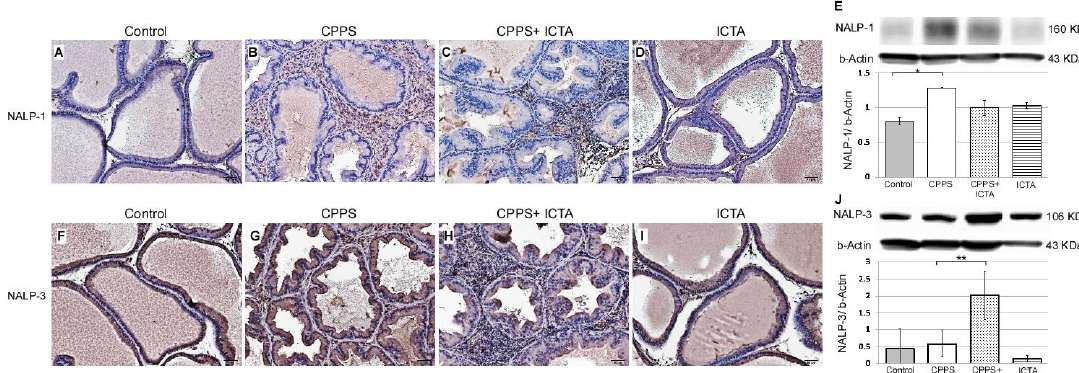
Figure 4. Inflammatory cytokine-targeting aptamers (ICTA) attenuated local carrageenan exposure-induced increases in inflammasome activation (NALP1) in rat prostate, but promoted NALP3 formation 168 h after carrageenan injection. ( A , B ) The expression levels of NALP1 and NALP3 following carrageenan injection in the prostate were elevated compared with those in the control group. ( C , D ) ICTA attenuated carrageenan-induced increase in the expression levels of NALP1 in the prostate of Sprague Dawley rats, but did not change much when treated alone compared to control. ( E ) Western blots demonstrate the expression ratio of NALP1 over internal control beta-Actin. The ratio is shown in y-axis. ( F – G ) Following carrageenan injection, the concentration of NALP1 in the prostate was elevated compared with that in the control group in the Sprague Dawley rats. ( H ) ICTA promoted carrageenan-induced increase in the concentration levels of NALP3 in the prostate of SD rats. ( I ) ICTA alone did not change the expression level of NALP3. ( J ) Western blots demonstrate the expression ratio of NALP3 over internal control beta-Actin. The ratio is shown in y-axis. The results are expressed as the mean + SD of six rats in each group and were analyzed by Student’s t-test. * p < 0.05 represents significance for the chronic pelvic pain syndrome (CPPS) group compared with the control group. ** p < 0.05 represents significance for the CPPS + ICTA group compared with the CPPS group ( n =